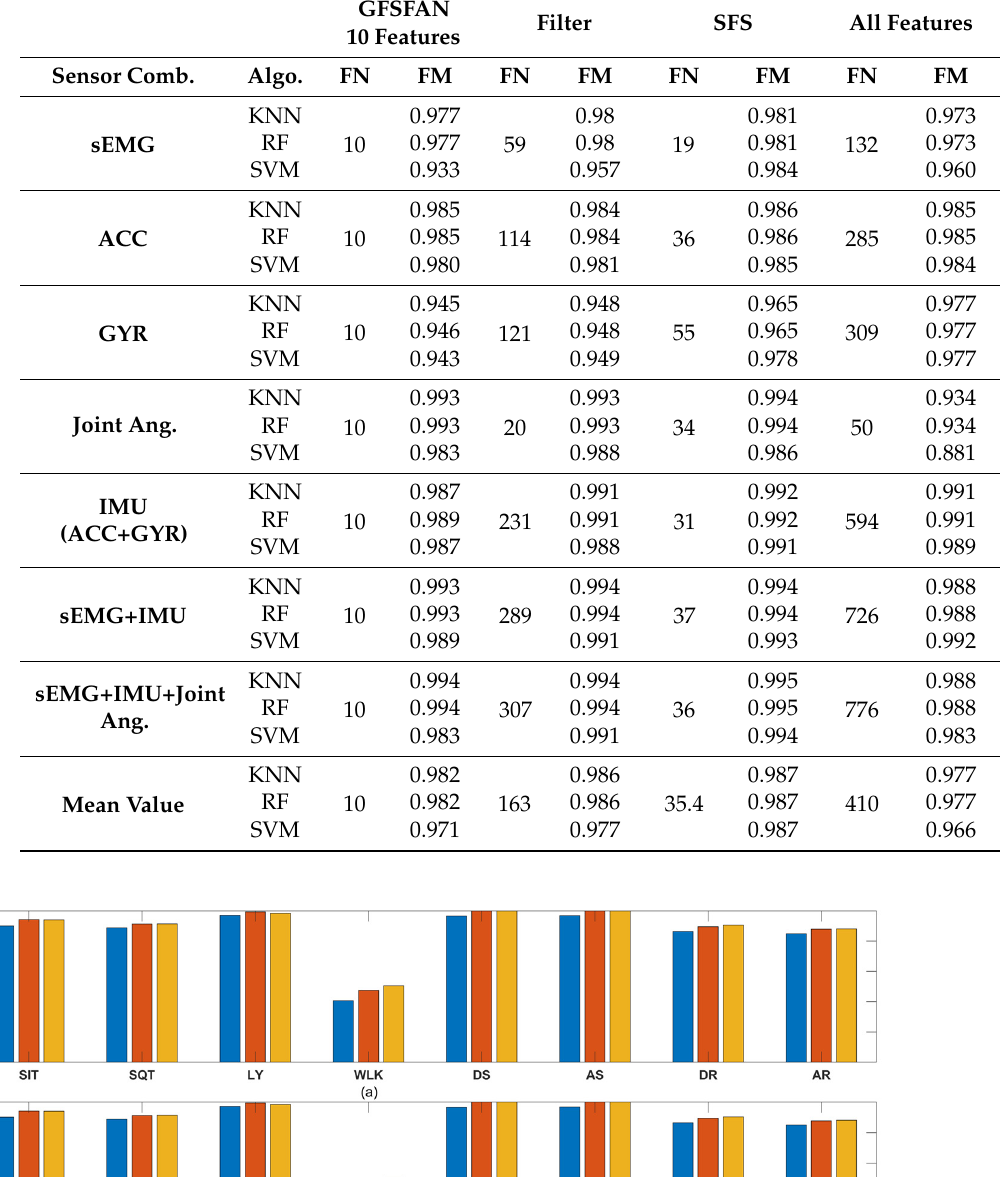
GFSFAN Filter 10 Features